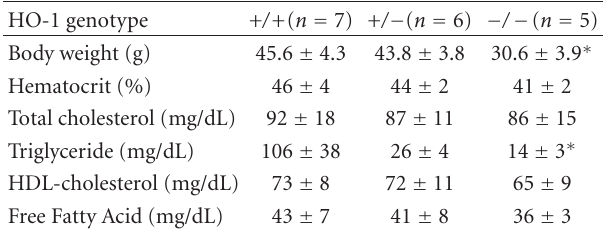
Figure 1: Severe aortitis, coronary arteritis and small atherosclerotic lesion on a standard rodent chow diet after 1 year old of HO-1 − / − mice. (a, g, h) Oil red O staining. (b, c, e, f) Hematoxylin- eosin staining. (d) Elastica Van Gieson staining. (d) Elastic fibers in the vessel walls are torn at the site of severe mononuclear cell infiltration. Magnifications at (a, e) × 40, (b) × 100, (c, d) × 200, and (f, g, h) × 400. Predominant sites of aortitis (b, c, d) and initial fatty streak formation (h) are indicated by arrows. These photomicrographs are representative of numerous sections examined. Table 1: Body weight and plasma lipid levels of HO-1-knockout